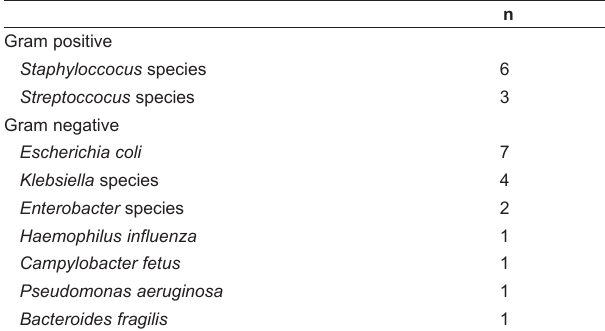
TAble 4 bacteriological confirmation in patients with